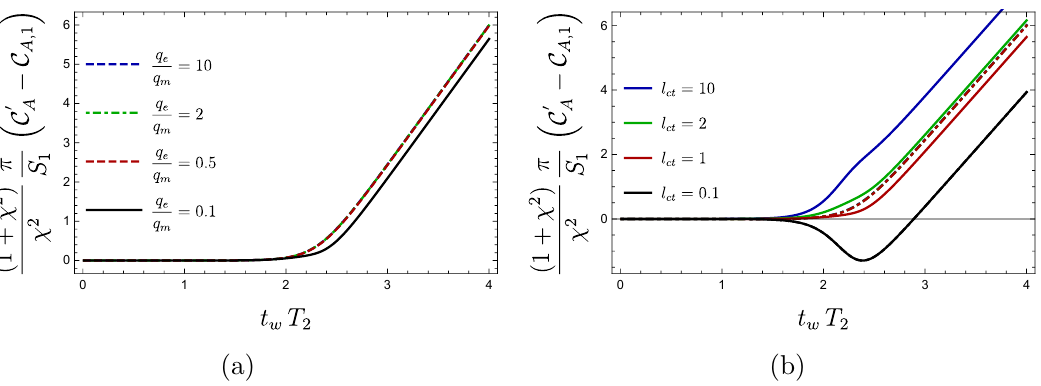
Figure 4 . (a) The complexity for the shock wave geometry as a function of the insertion time t w , for a light shock wave r + ; 2 = (1 + 10 (cid:0) 6 ) r + ; 1 and parameters L = 0 : 5 r + ; 2 , r (cid:0) ; 1 = 0 : 5 r + ; 2 and ‘ = L . (Further, r (cid:0) ; 2 is determined by (cid:12)xing q to be the same before and after the shock wave.) ct T We show the result for rescaling the curves in (cid:12)gure 3 by the factor (1 + (cid:31) 2 ) =(cid:31) 2 . We essentially see that the curves lie on top of each other, except the for smallest (cid:31) , as it is more sensitive to the transient behaviour controlled by ‘ . (b) The in(cid:13)uence of the transient behaviour for the ct complexity in the shock wave geometry. We show in solid (cid:31) = 0 : 1 and in dot-dashed (cid:31) = 10 to contrast the e(cid:11)ect of varying ‘ in units of L. For ‘ = 0 : 1 L , both curves are essentially on top of ct ct each other, but for ‘ (cid:24) L , the curves with small (cid:31) are more sensitive to this ambiguous scale. ct